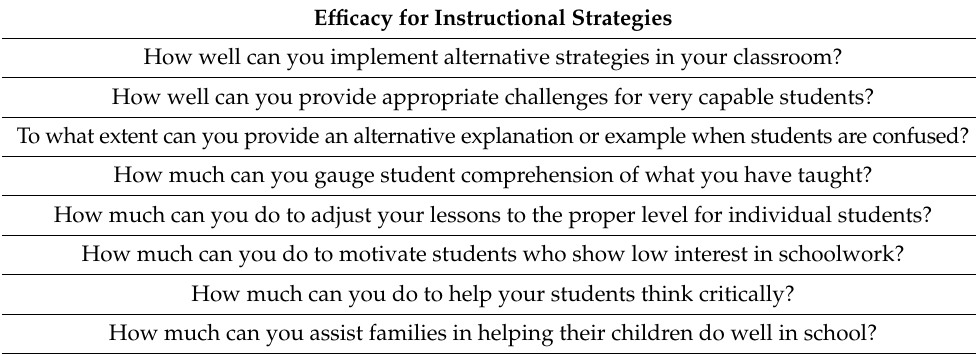
Table 3. Items making up the Efficacy for Instructional Strategies factor.